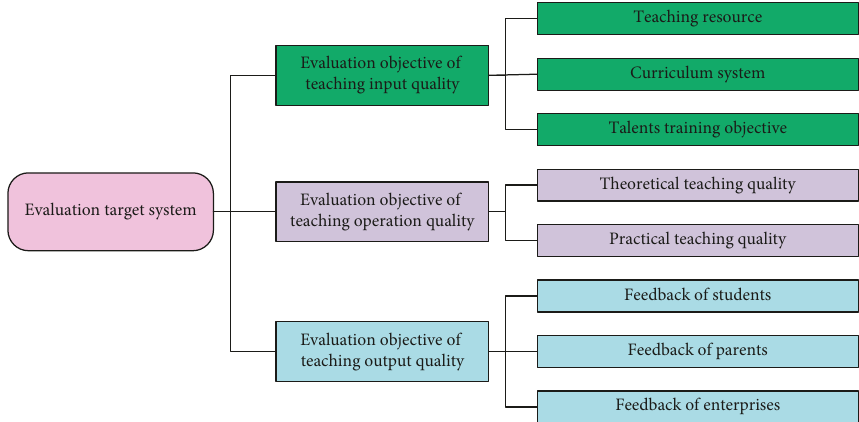
Figure 1: Performance evaluation target system of IEE in all kinds of colleges and universities. Table 1: Performance evaluation index system of IEE in all kinds of colleges and universities.